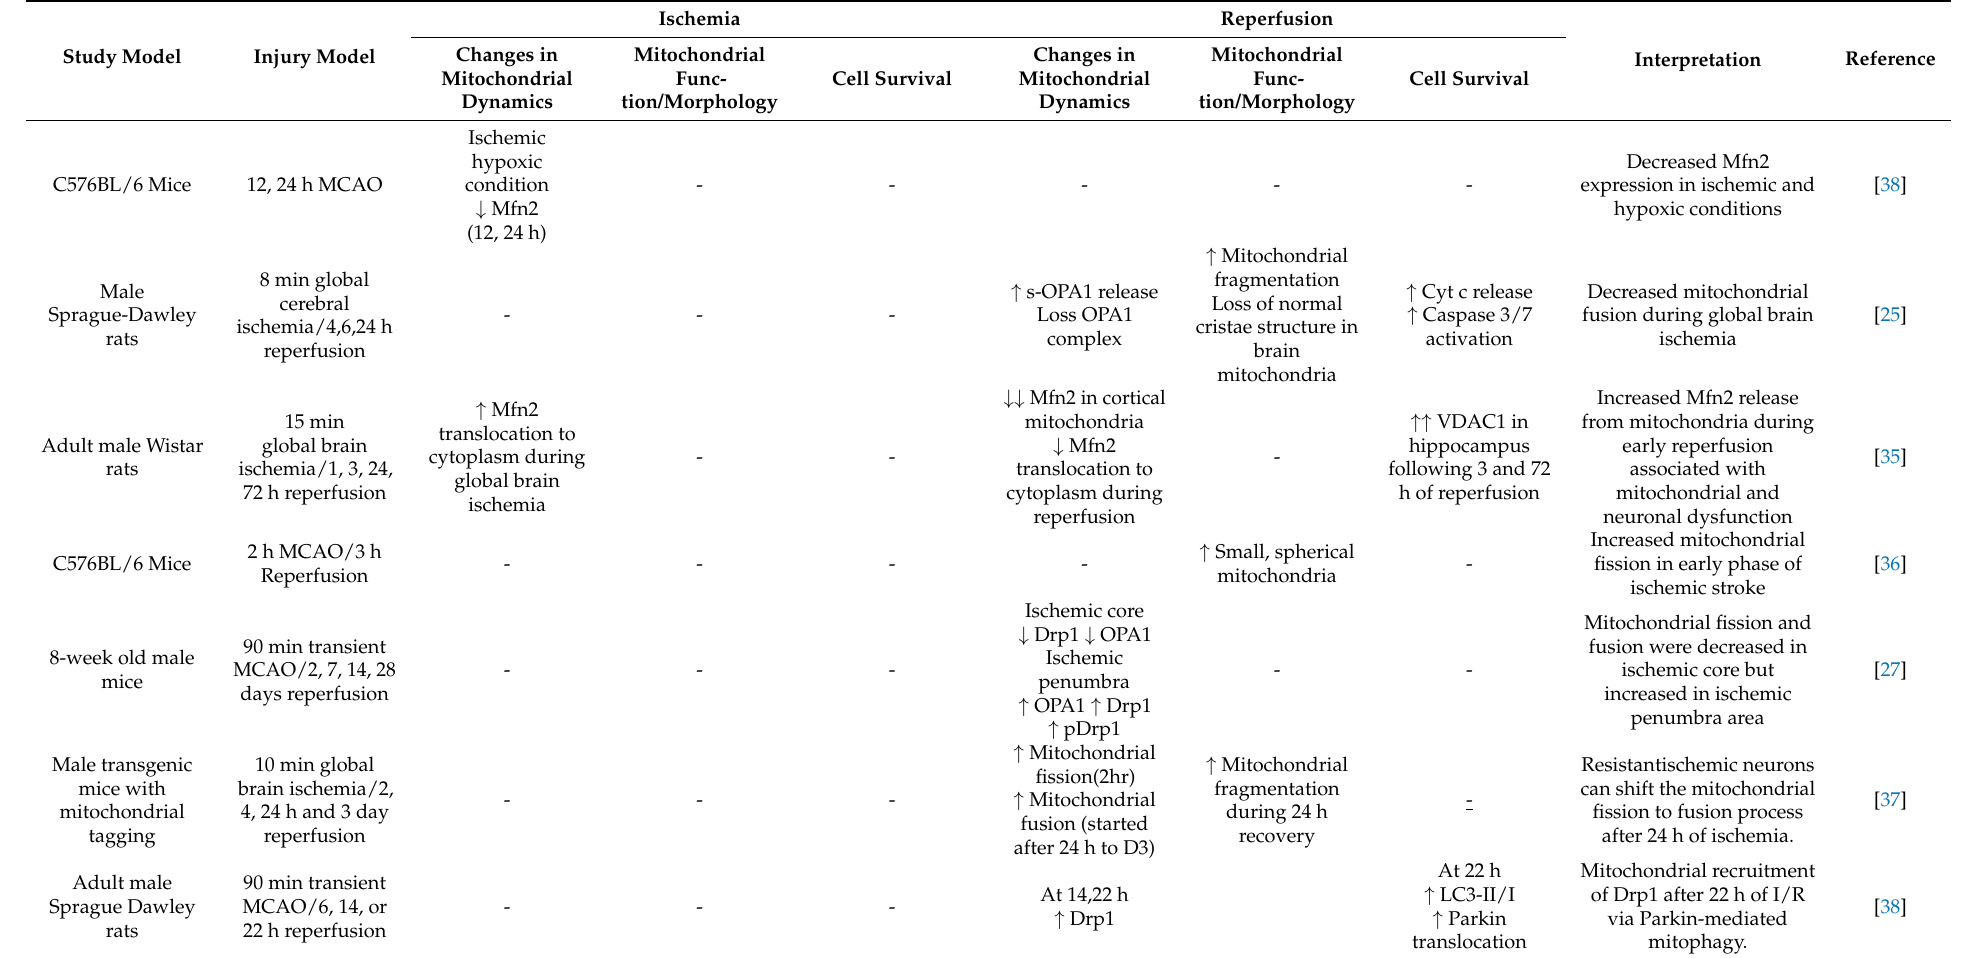
Table 2. Evidence in the alterations in mitochondrial dynamics following cerebral ischemia/reperfusion injury: in vivo